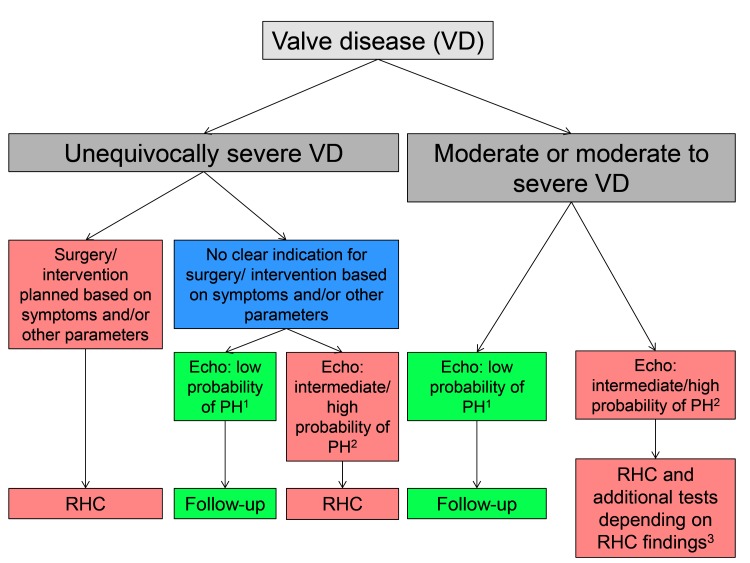
 Suggested algorithm to detect pulmonary hypertension (PH) using echocardiography (echo) and right heart catheterization (RHC) in patients with left-sided valve disease (VD, i.e., mitral stenosis and/or regurgitation, aortic stenosis and/or regurgitation). 1low probability of PH: peak TRV ≤2.8 m/s and no indirect echocardiographic signs of PH 2intermediate probability of PH: peak TRV ≤2.8 m/s but indirect signs of PH or if peak TRV but without indirect signs of PH, high probability of PH: peak TRV 2.9–3.4 m/s with indirect signs of PH or peak TRV ≥3.4 m/s regardless of indirect signs of PH 3please see Figure 3.